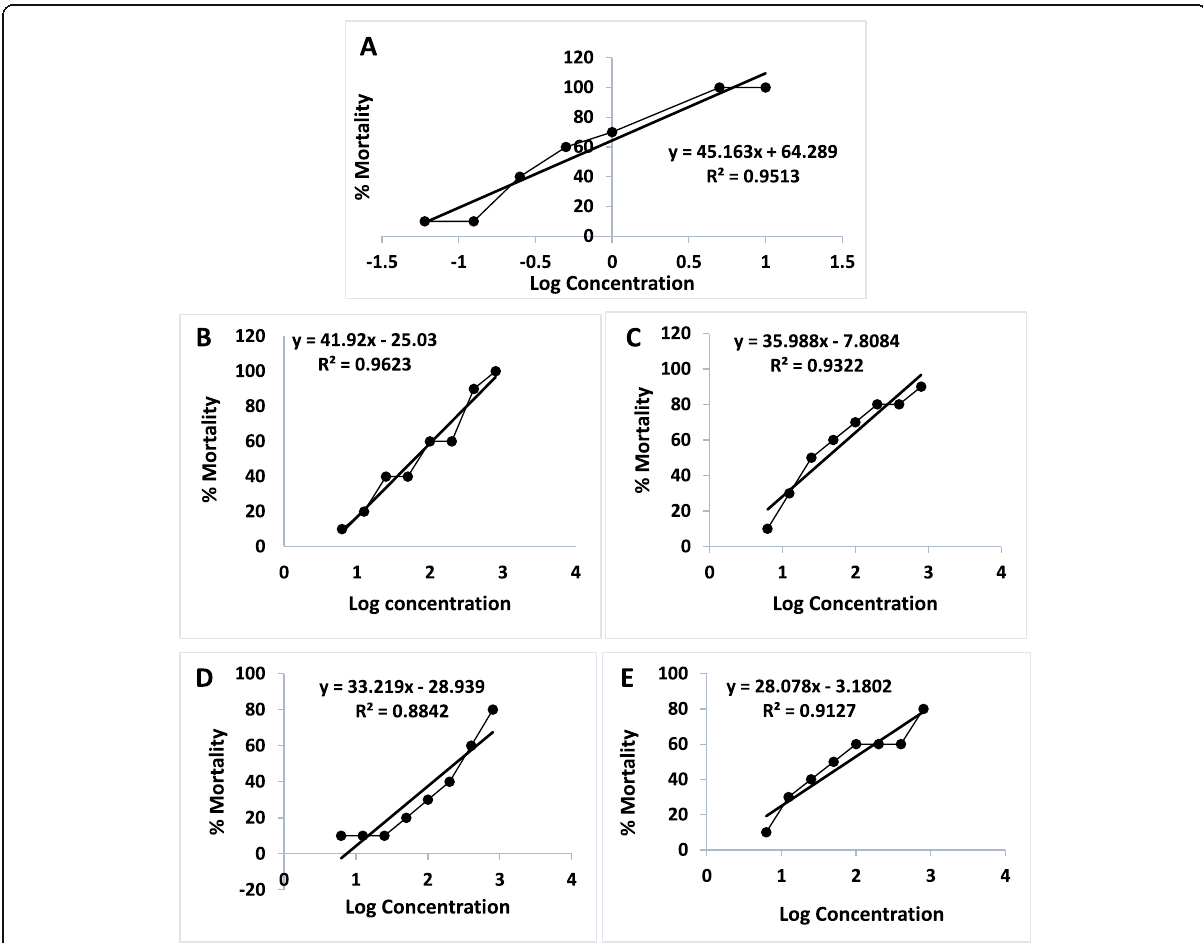
Fig. 3 Effect of test extracts ( n = 3) at different concentrations (in logarithm) on mortality rate (%) of brine shrimp nauplii. a Vincristine sulphate, b Ethanolic extract of Terminalia citrine (Roxb.), c Methanolic extract of Terminalia citrine (Roxb.) , d Ethanolic extract of Desmodium triflorum (L.) , e Methanolic extract of Desmodium triflorum (L.). n = number of sample. y = dependent variable (% mortality), x = independent variable (log concentration), R 2 = Coefficient of determination representing how close the data (dependent and independent variables) are to the fitted regression line; a value close to 100% (1.00) is recognized as best fitted line (linear relationship between dependent and independent